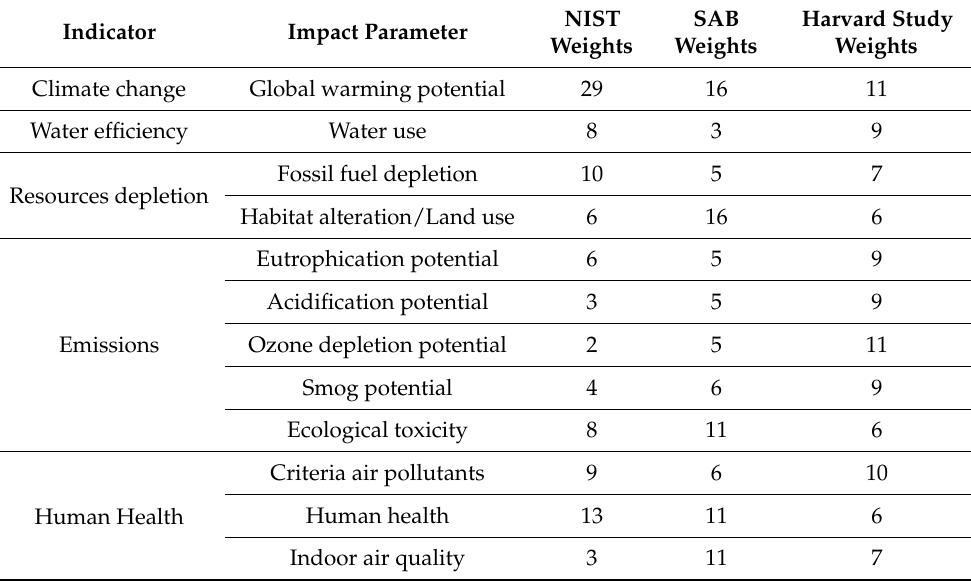
Table 1. Relative weights of LCI impact